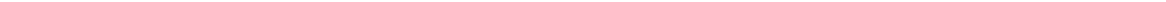
Fig. 4 BubR1 associated PP2A, but not KNL1 associated PP1, plays a signi fi cant role in the end-on conversion process. a Experimental regime: BubR1 siRNA treated HeLa FRT/TO cells conditionally expressing Venus (YFP)-BubR1 (WT or Δ 660 – 685 mutant) were exposed to Doxycycline for 24 h and MG132 for 1 h prior to immunostaining. b Images of cells treated as in a , immunostained with antibodies against GFP, Tubulin and Astrin and stained with DAPI for DNA. Scale: 5 µ m in uncropped and 1 µ m in cropped images. Boxed areas correspond to cropped images. c Graph of Astrin intensities on congressed or uncongressed kinetochores in cells expressing Venus (YFP) tagged -BubR1 WT or Δ 660 – 685 mutant, as in b . Horizontal lines show average values (in green ) across KTs from two independent experiments. Each circle represents values from one kinetochore. d Images of cells treated as in a , immunostained with antibodies against GFP and Tubulin and CREST anti-sera and stained with DAPI for DNA. Scale: 5 µ m in uncropped and 1 µ m in cropped images. Boxed areas correspond to cropped images. e Graph shows percentage of lateral vs. end-on kinetochores in Venus-BubR1 (WT or Δ 660 – 685 mutant) expressing cells treated as in d . Each circle represents values from one cell. Black bar marks average values from four independent experiments. f Images of KNL1 siRNA treated HeLa cells expressing LAP-tagged KNL1 WT or mutants (2A or 4A). Following plasmid transfection, cells were exposed to Doxycycline for 1 h and then incubated in Doxycycline-free media for 30 h. Prior to fi xation cells were exposed to MG132 for 45 min and immunostained with antibodies against GFP, Tubulin and Astrin. Scale: 5 µ m in uncropped and 2 µ m in cropped images. Boxed areas correspond to cropped images. g Graph shows percentage of lateral vs. end-on kinetochores in LAP tagged KNL1 (WT, 4A or 2A mutant) expressing cells, treated as in f . Each circle represents values from one cell. Black bar marks average values from three independent experimental repeats. In c , e and g , ‘ * ’ and # indicate statistically signi fi cant and insigni fi cant differences, respectively (assessed using P -values from unpaired Student ’ s t